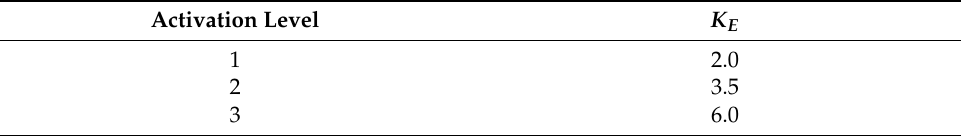
Figure 18. Layout of the control flow for the 2 DOF controller. The values of K P , K I , and K D were taken from the tuned PID controllers for each activation level. Table 11. Tuned 2 DOF controller